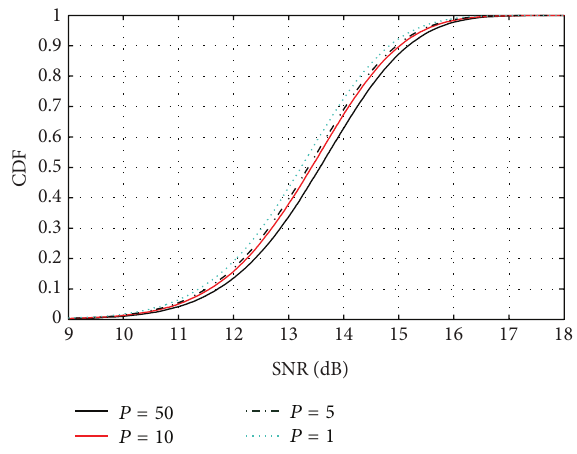
Figure 13: Tropospheric scintillation effect at different 𝑃 .